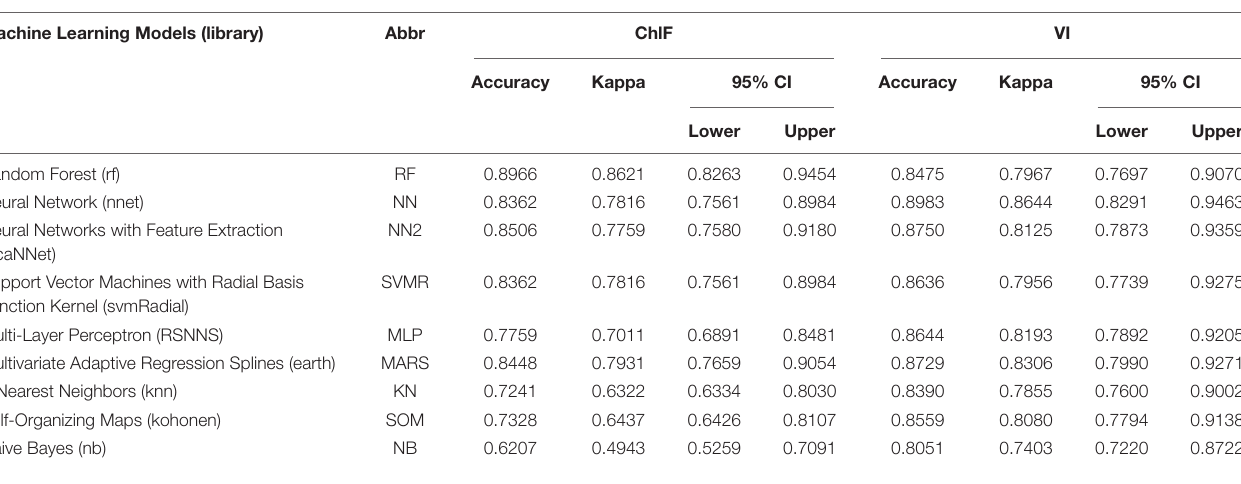
TABLE 2 | Machine learning models and their classification accuracies. Machine Learning Models